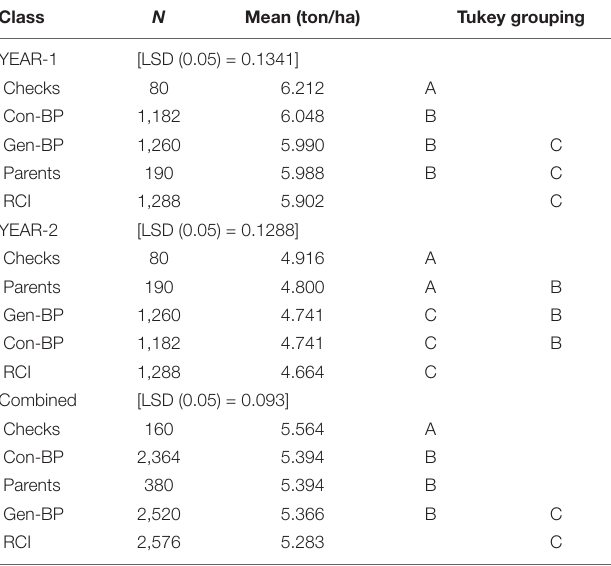
TABLE 3 | Experiment 1: Least significant difference (LSD), mean yield comparison of different breeding populations and checks evaluated at